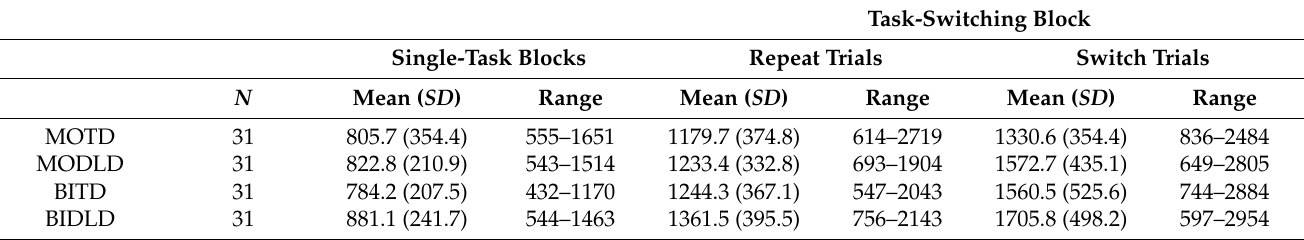
Table 4. Reaction times (in milliseconds) of the four groups of